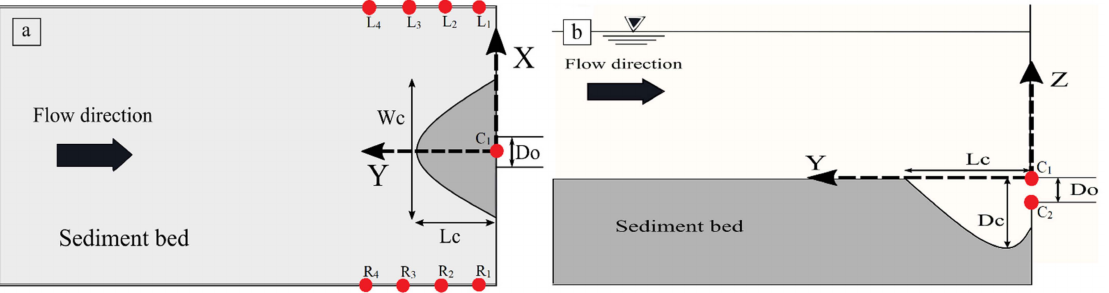
Figure 1. Schematic representation of MCPs in the coordinate system of the experimental setup: top view ( a ) and side view ( b )